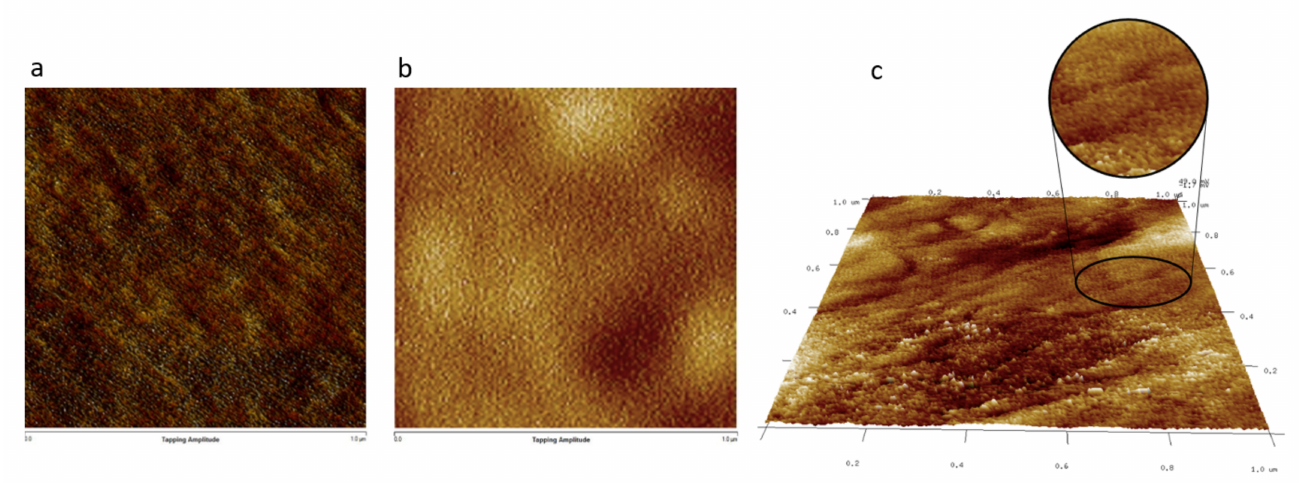
Figure 3. AFM images of the PAMPS- b -PMMA-1:1 membrane: ( a ) thermally annealed at 120 ◦ C for 72 h, ( b ) microwave-annealed for 180 s in the presence of toluene solvent, and ( c ) the 3-dimensional texture of the image in ( b